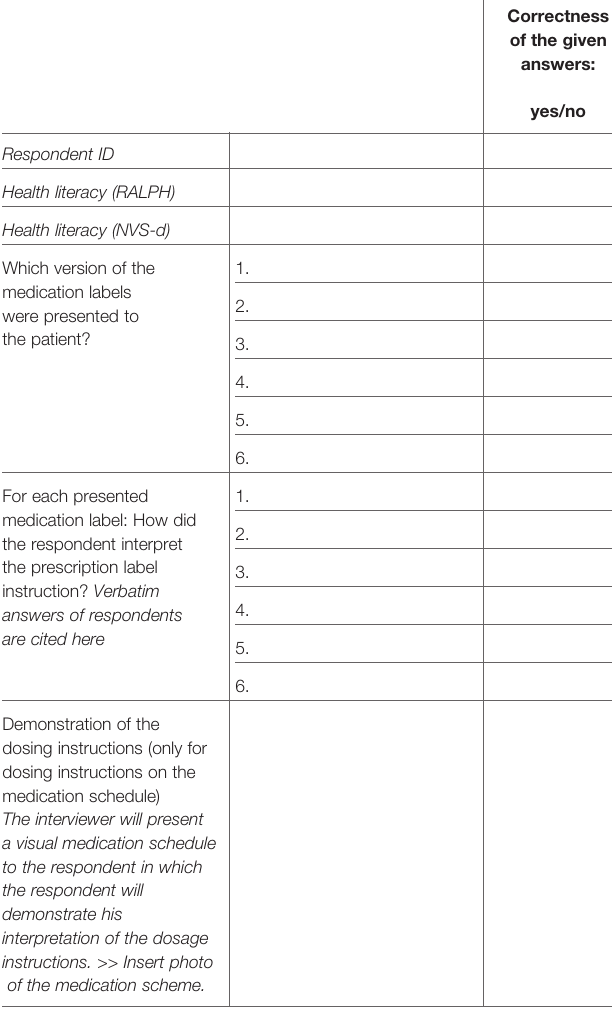
TABLE 2 | Coding scheme for the patient study in phase 2a.